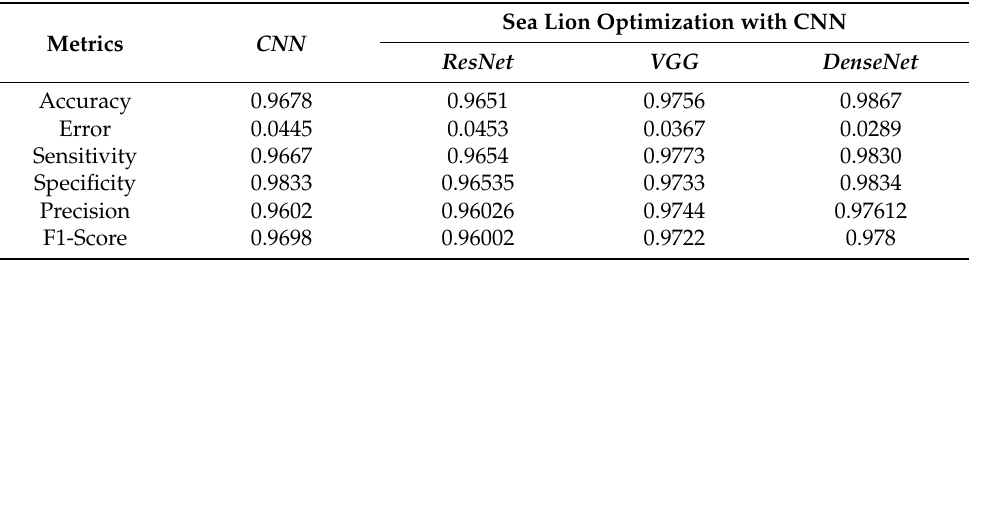
Table 13. Performance value of